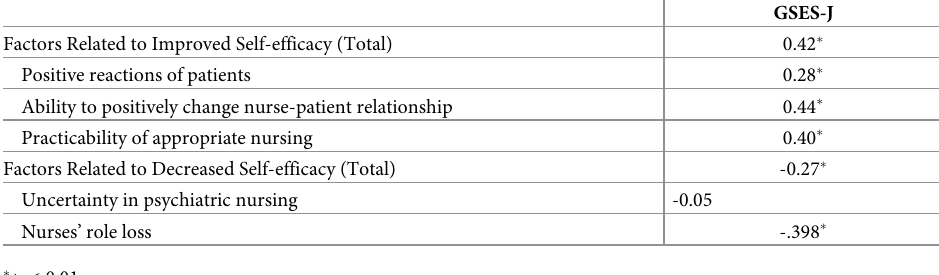
Table 5. The factors related to self-efficacy and the GSES-J